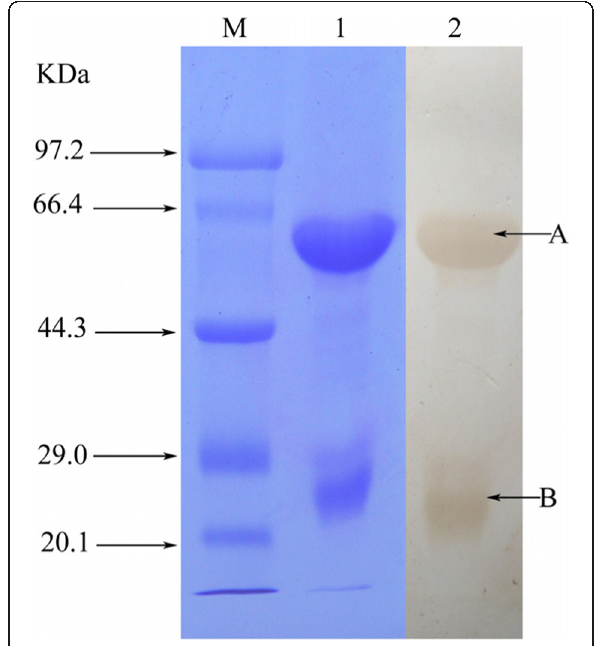
Fig. 4 Anti- T. albolabris venom IgY combined with venom proteins by Western blot analysis. Lane 1: 50 μ g of venom on 10 % SDS-PAGE; lane 2: 50 μ g of venom; lane 3: 25 μ g of venom; and lane 4: 12.5 μ g of venom combined with a fixed amount of anti- T. albolabris venom IgY